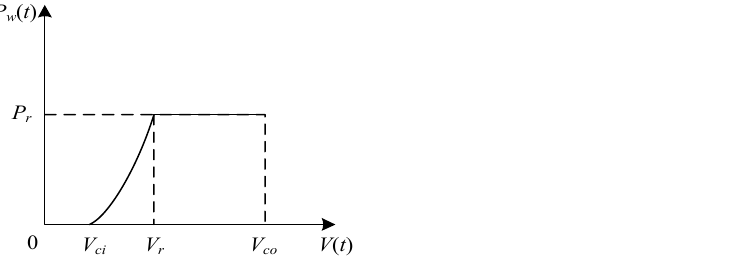
Figure 2. Variation curve of wind farm output power with wind speed [36].